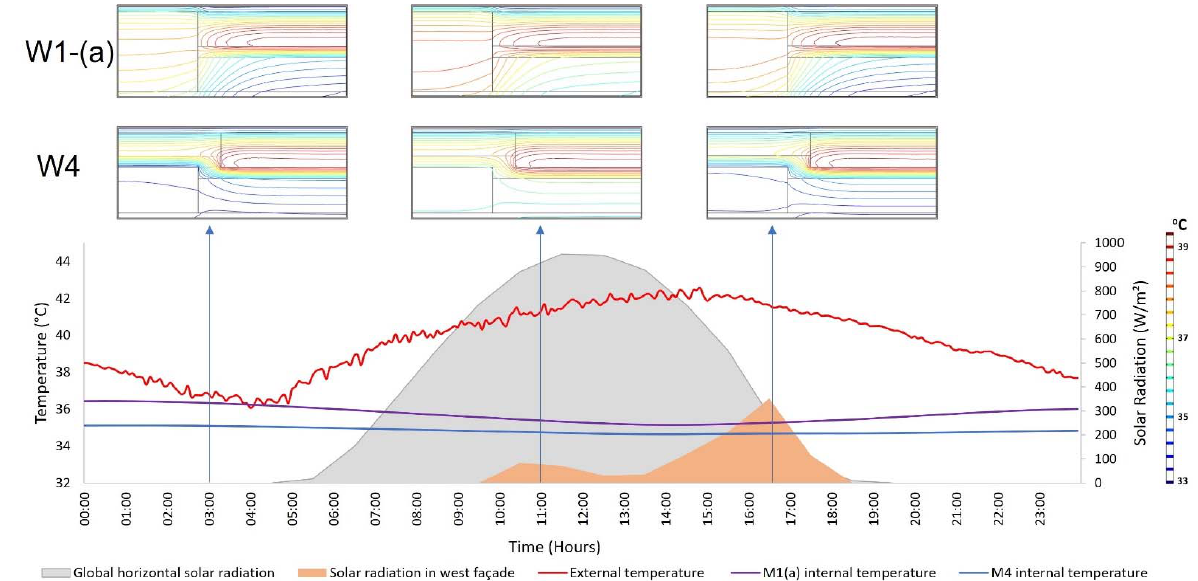
Figure 14. Modelled heat transfer through the walls W1-(a) and W4 (surface temperature distribution) at 3 different times during the 24 h period, corresponding with external and internal temperature and solar radiation. Table 8. Wall system specifications and the effective U t ‐ values of the different wall systems.